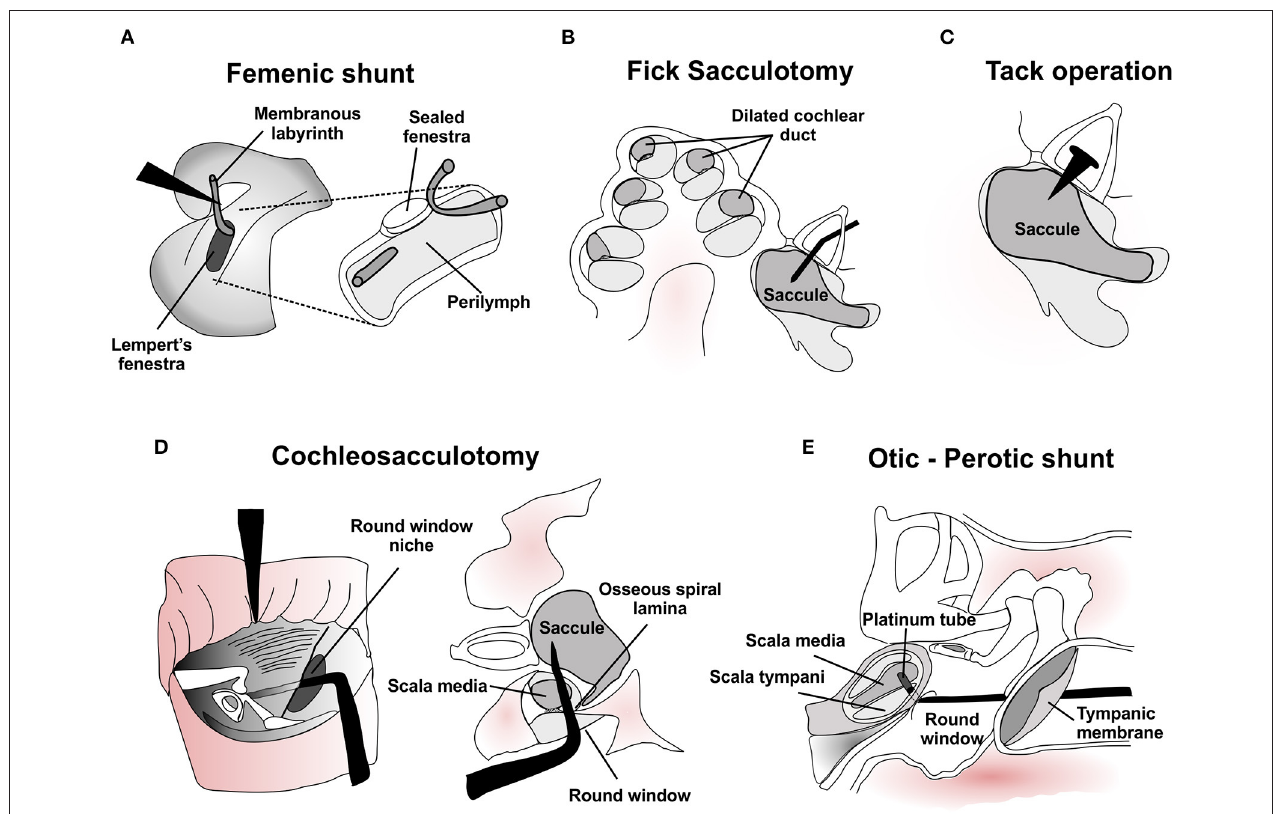
FIGURE 1 | Surgical manipulations of the membranous labyrinth for treatment of Meniere’s disease. (A) Depiction of Femenic’s shunt in the lateral semicircular canal to relieve endolymphatic hydrops and vertigo episodes. Adapted with permission from Femenic (25). (B) Histological representation of endolymphatic hydrops in the cochlear duct and saccule, with a Fick sacculotomy needle placed through a fenestration in the stapes to drain excess endolymph. (C) Permanent tack placement in the stapes bone was intended to enable repeated decompression of the hydropic saccule in the Cody tack operation. (D) Two views of the cochleosacculotomy procedure, where a 90-degree pick is driven through the round window to rupture the cochlear duct and saccule and create a permanent fistula in the osseous spiral lamina. Adapted with permission from Schuknecht ( 26) and Kinney et al. (27). (E) Depiction of the Otic-Perotic shunt procedure, where a platinum tube is placed in the basilar membrane of the basal cochlea to enable decompression of the scala media. Adapted with permission from Pulec (28,